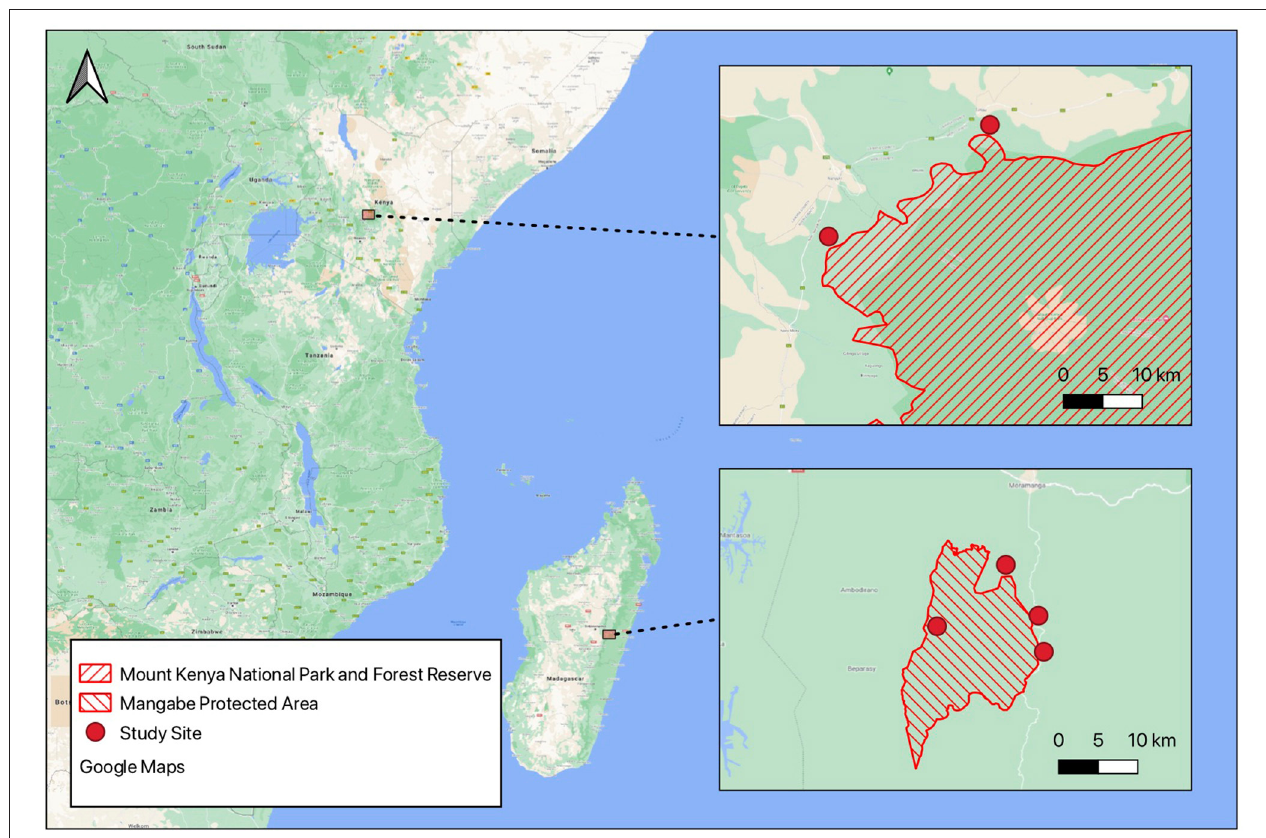
FIGURE 3 | Study sites (four villages near the Mangabe protected area in eastern Madagascar, and two villages adjacent to Mount Kenya National park in